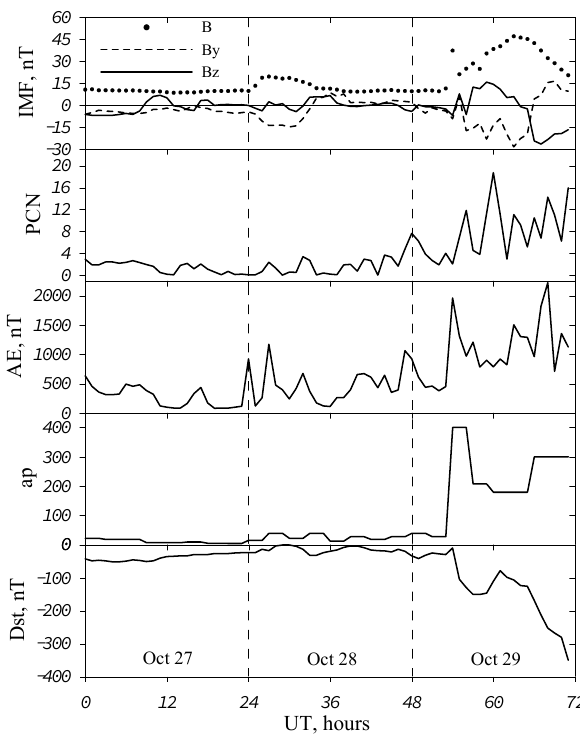
Fig. 1. Helio-geophysical parameter variations for the 27–29 Octo- Fig.1. ber 2003